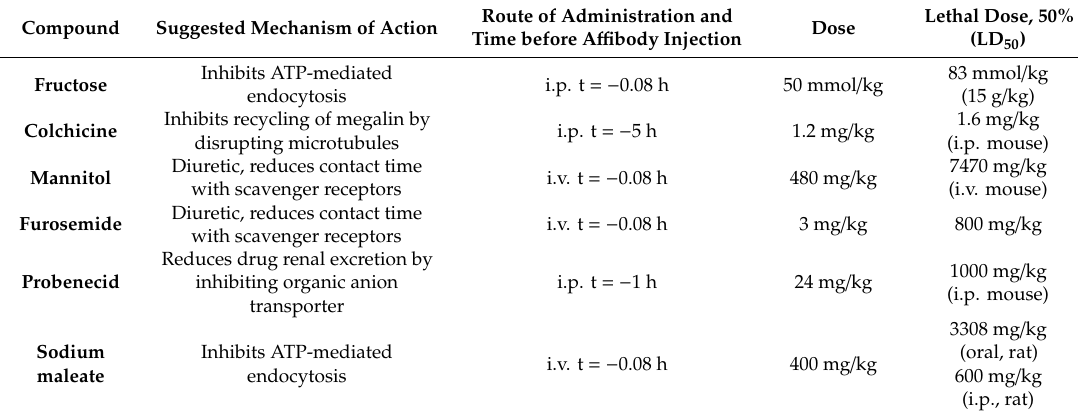
Table 1. List of compounds administered before the injection of [ 99m Tc]Tc-Z HER2:2395 in Naval Medical Research Institute (NMRI) mice.